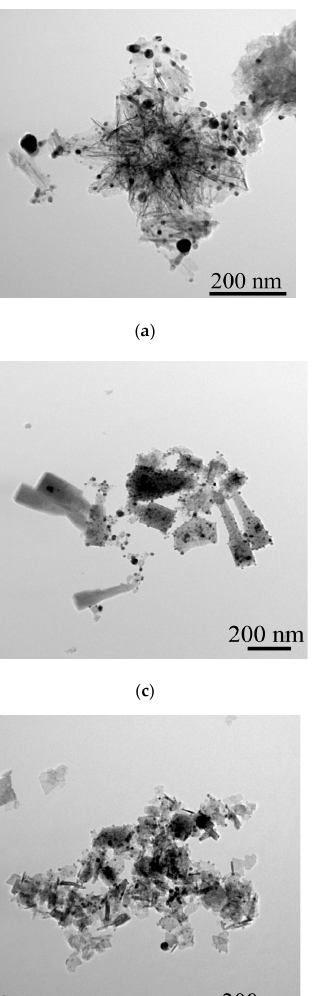
Figure 10. DSC–TG curves of the synthesized nanoscale structures: 1—sample 1; 2—sample 2; 3—sample 3.